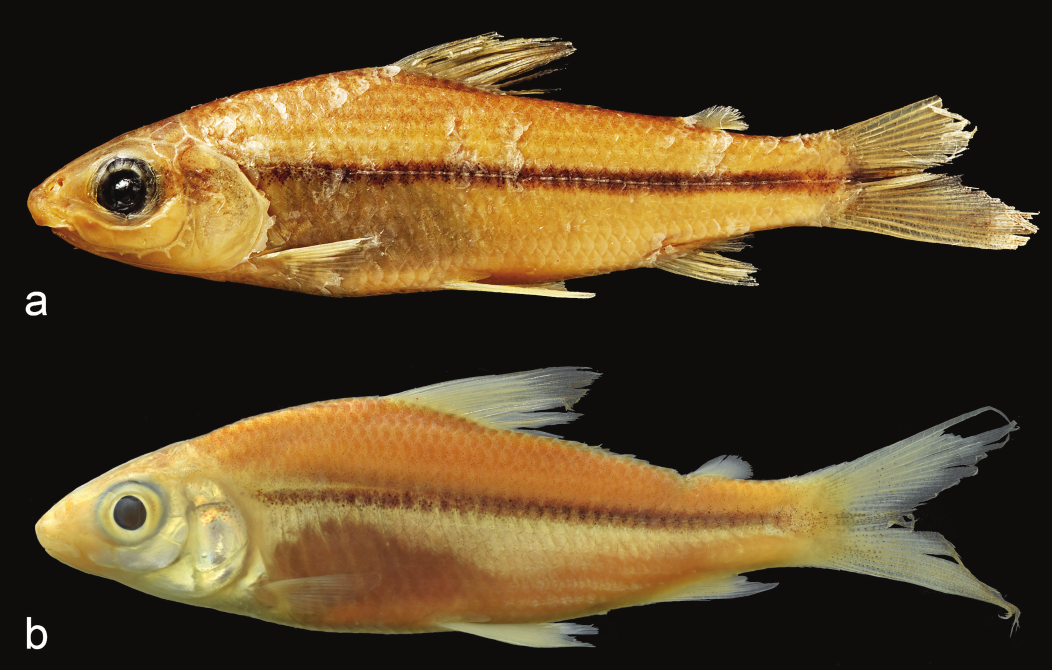
Fig. 2. a. Steindachnerina nigrotaenia , lectotype of Curimatus nigrotaenia , BMNH 1902.2.10.30, 43.5 mm SL, Brazil, Mato Grosso, rio Coxipó, upper rio Paraguai; b. LBP 1477, 43.4 mm SL, Brazil, Mato Grosso do Sul, Coxim, rio Taquari, upper rio